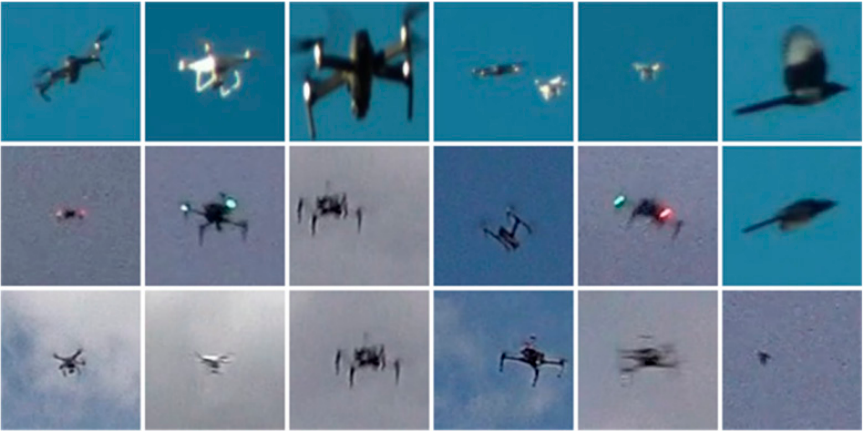
Figure 3. Examples of candidate areas that may contain interference targets, such as birds.